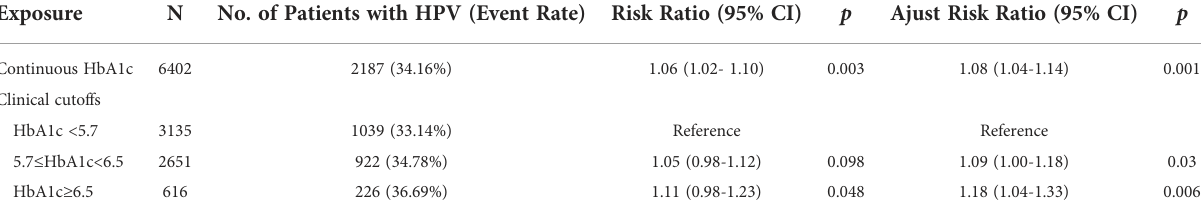
TABLE 3 Risk Ratios for HPV among different level of